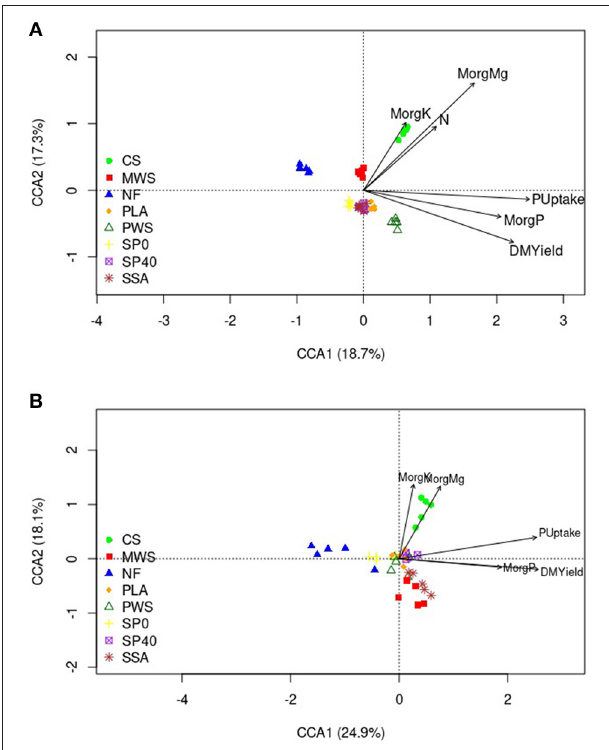
FIGURE 5 | CCA biplot of (A) bacterial OTU data (B) nematode OTU data and the soil variables that were significantly associated. Arrows indicate the direction and magnitude of measurable variables significantly associated with the community structures. Treatment group name: NF, No fertilizer; SP0, No phosphate; SP40, mineral super phosphate; CS, cattle slurry; PWS, potato waste struvite; MWS, municipal waste struvite; PLA, poultry litter ash; SSA, sewage sludge